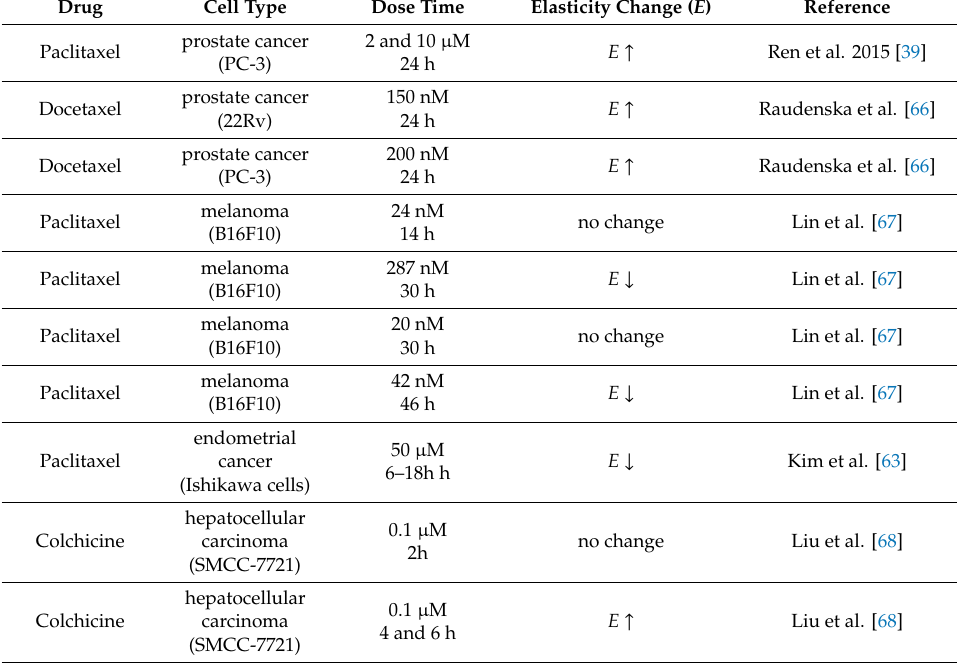
Table 1. Mechanical properties of cancerous cells measured by AFM, treated mainly with